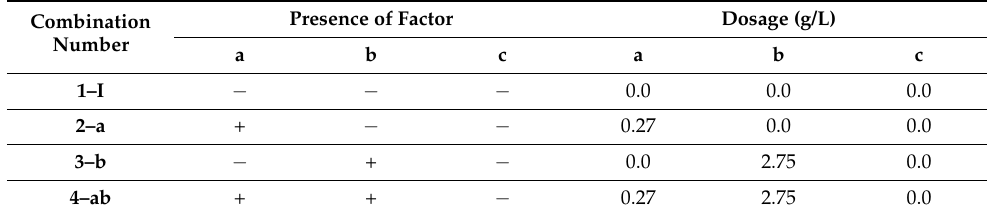
Table 8. Trial planning matrix with doses of fertilizing agents depending on the combination. Combination